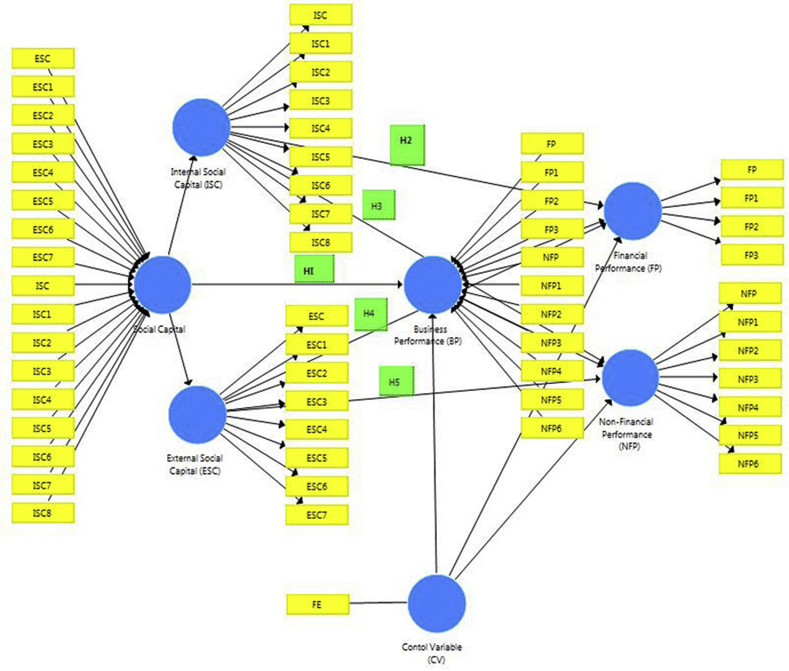
Conceptual model.